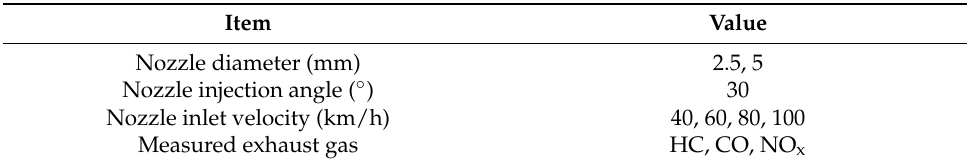
Table 5. Experimental conditions.